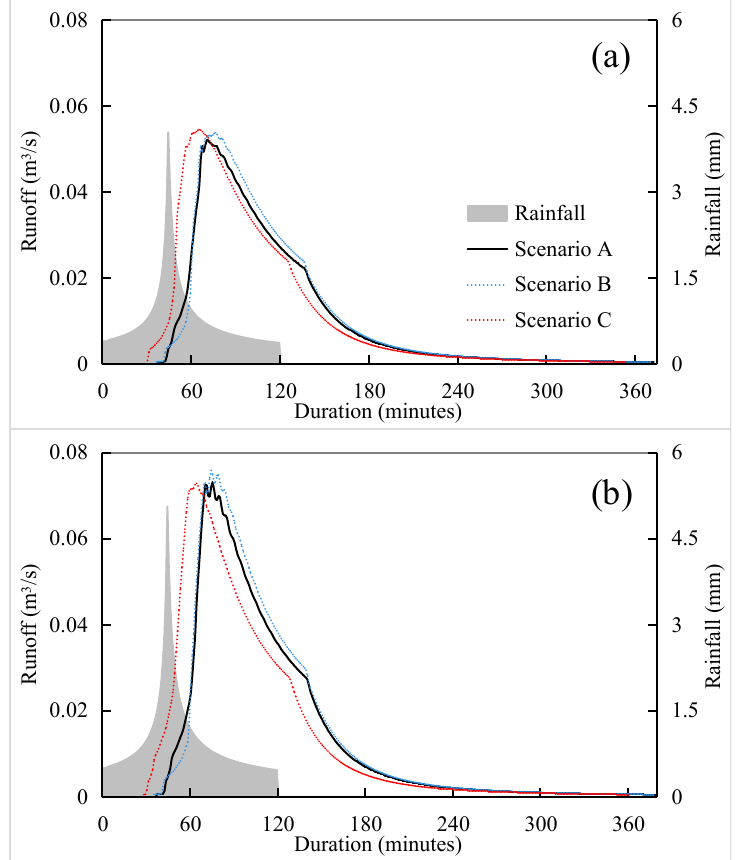
Figure 4. Runoff processes derived from the three LID connection scenarios under the rainfall with the return periods of 5 years ( a ) and 20 years ( b ).